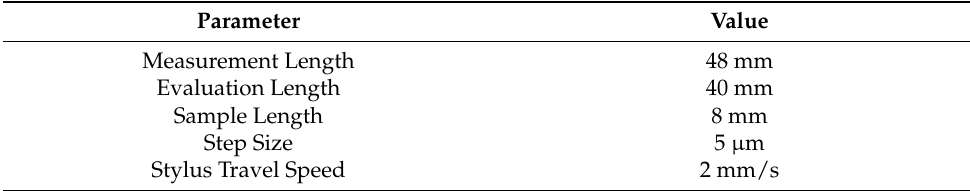
Table 3. Roughness measurement